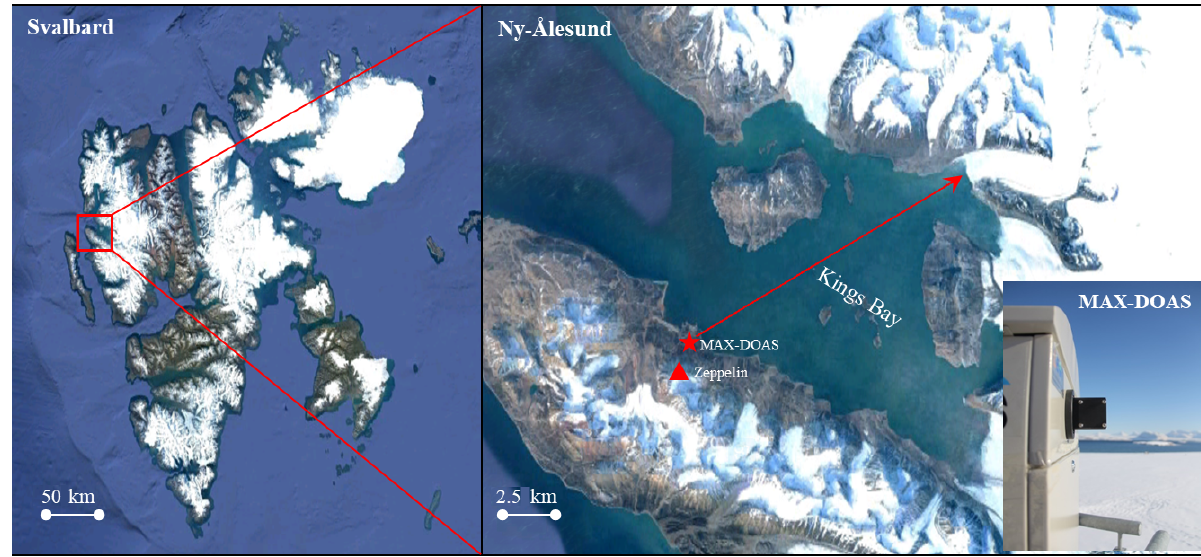
Figure 3. The MAX-DOAS field observation in Ny-Ålesund, Arctic.